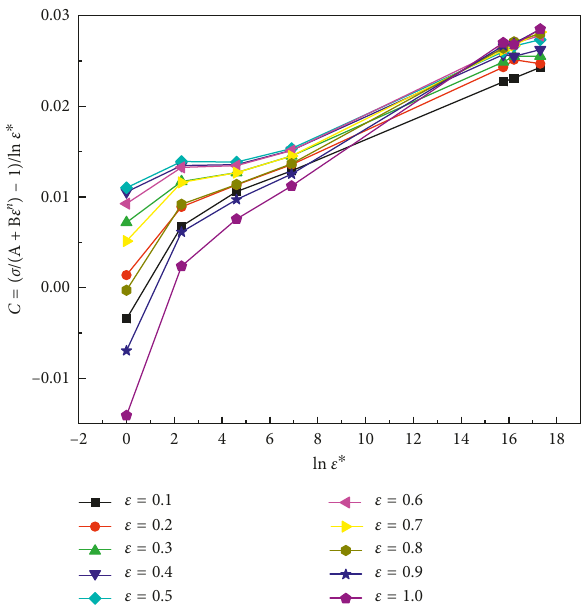
Figure 9: Relationship between C and In _ ε